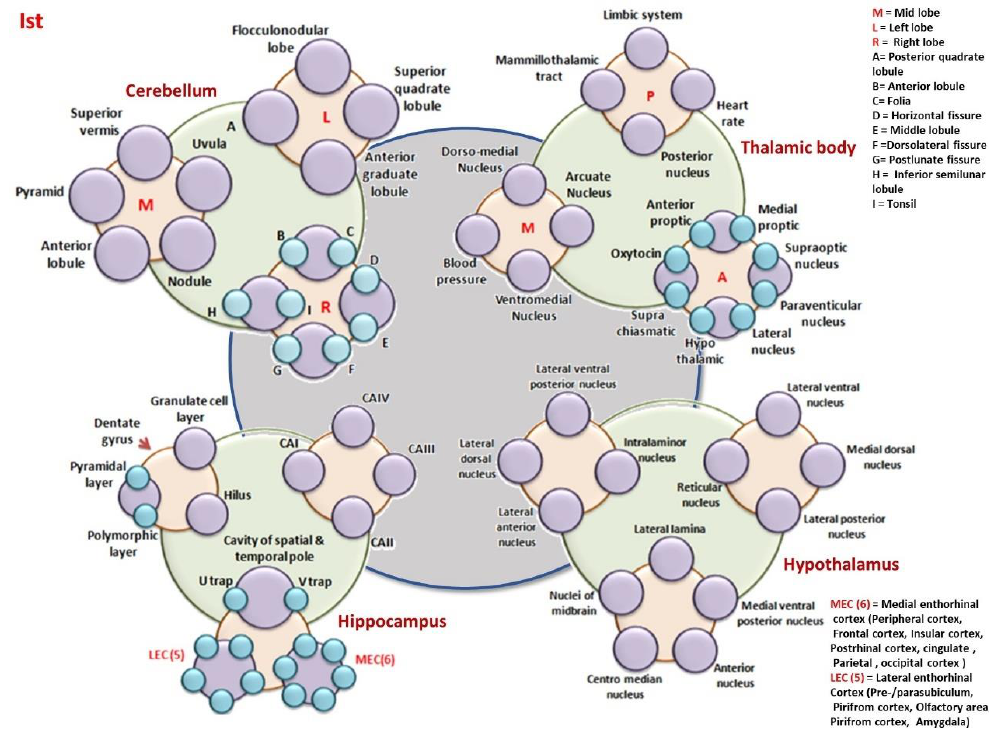
Figure 11. Four di ff erent brain components- Cerebellum, hippocampus, hypothalamus and thalamic Figure 11. Four different brain components- Cerebellum, hippocampus, hypothalamus and thalamic body are four body are four components.